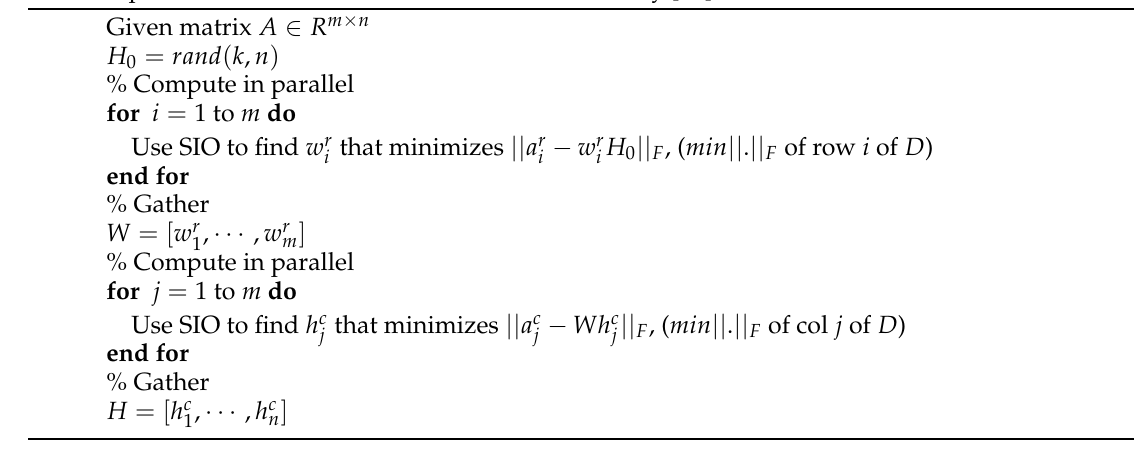
Algorithm 2: Pseudo code for the initialization procedure for NMF factors W and H . The two for-loops in lines 4 and 10 can be executed concurrently